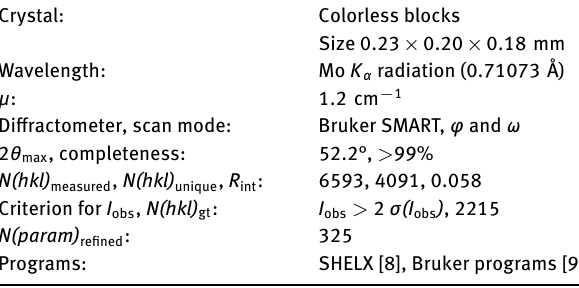
Table 2: Fractional atomic coordinates and isotropic or